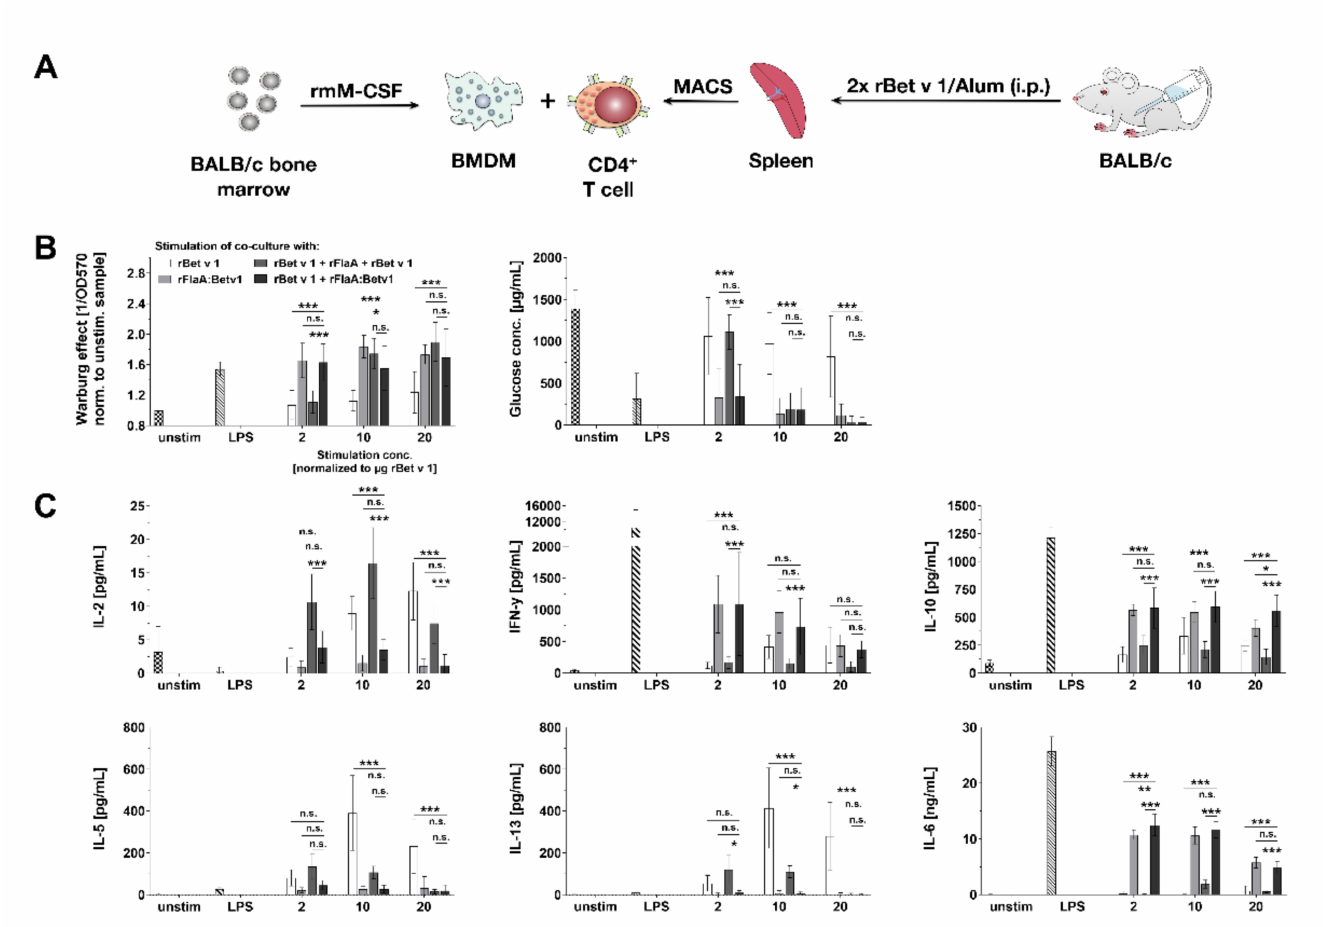
Figure 7. rFlaA:Betv1 suppresses rBet v 1-specific Th2 responses in vitro. BALB/c BMDMs were differentiated from mouse bone marrow, co-cultured with CD4 + T cells isolated by magnetic activated cell sorting (MACS) from rBet v 1 plus Alum-sensitized mice and stimulated with the indicated equimolar protein amounts or LPS as a positive control for 96 h ( A ). Supernatants were analyzed for their metabolic state ( B ) and cytokine secretion by ELISA ( C ). Data are mean results of three independent experiments ± SD with two technical replicates per experiment. Statistical significance indicated as: n.s. p -value > 0.05, * p -value < 0.05, ** p -value < 0.01, *** p -value <